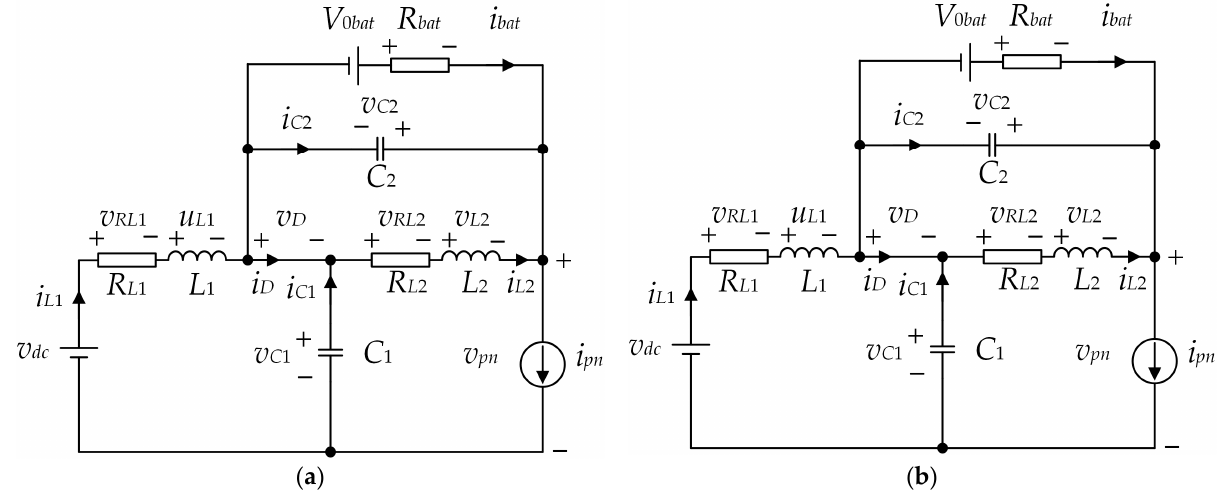
Figure 10. Equivalent circuits of the battery-assisted qZSI: non-ST state ( a ) and ST state ( b ). The amount of the DC voltage boost depends on the ST duty ratio, i.e., the ratio of the ST state period ( T 0 ) and the switching period ( T ). Consequently, the amplitude modulation index ( M ) and the ST duty ratio ( D 0 ) of the qZSI can be utilized to achieve the required AC load voltage for any given value of the DC-bus voltage within the qZSI normal operating range. This is evident from the equations provided for the qZSI boost factor ( B ) and gain ( G ). The boost factor represents the ratio between the peak value of the voltage across the qZSI bridge ( V pn_peak ) and the DC-bus voltage ( V dc ), and it is given as